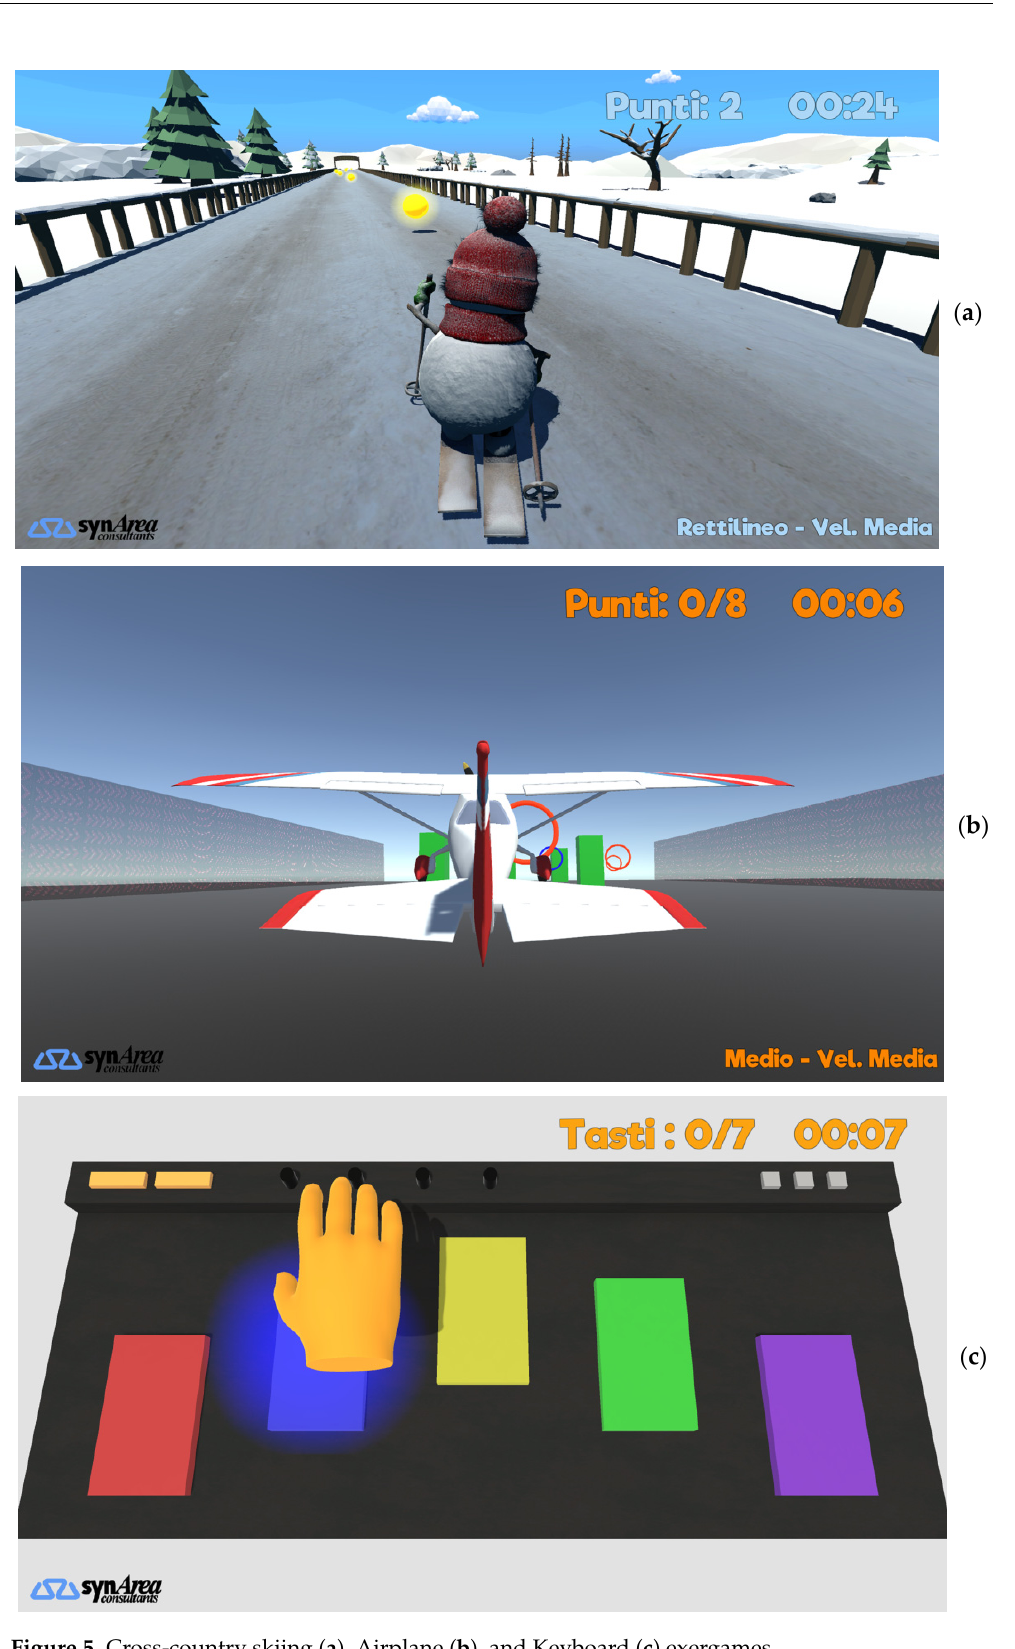
Figure 5. Cross-country skiing ( a ), Airplane ( b ), and Keyboard ( c ) exergames.